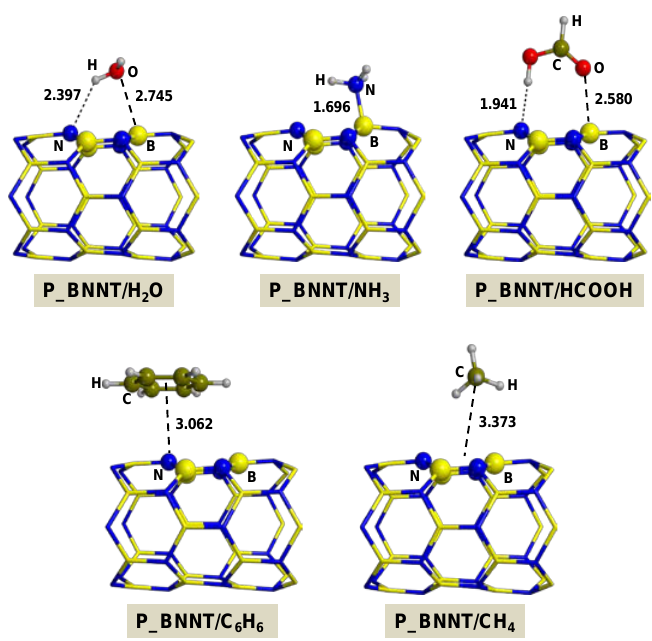
Figure 2. B3LYP-D2* optimized structures of the probe molecules interacting with P_ BNNT. Bond distances are in Å. The distances for P_BNNT/C 6 H 6 are those between the centroid of the aromatic ring and the plane defined by the closest BN hexagon ring; for CH 4 , they are between the C atom and the plane defined by the closest BN hexagon ring. Table 1. Calculated adsorption energies ( ∆ E ads ), including the pure potential energy contribution ( ∆ U) and the contribution of dispersion ( ∆ E D ), of the probe molecules on the different BNNTs. The calculated Mulliken charges (Q) of the probe molecules adsorbed on the BNNTs, and calculated direct band gaps (E g ) of the adducts are also